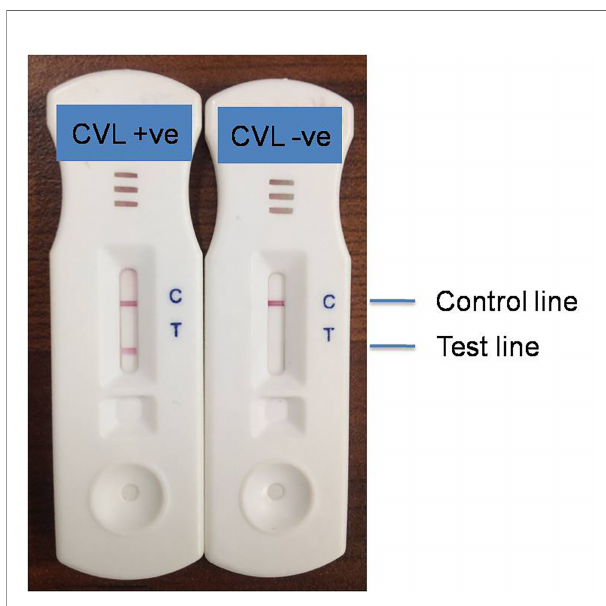
FIGURE 3 | Representative result of ICT with positive and negative CVL